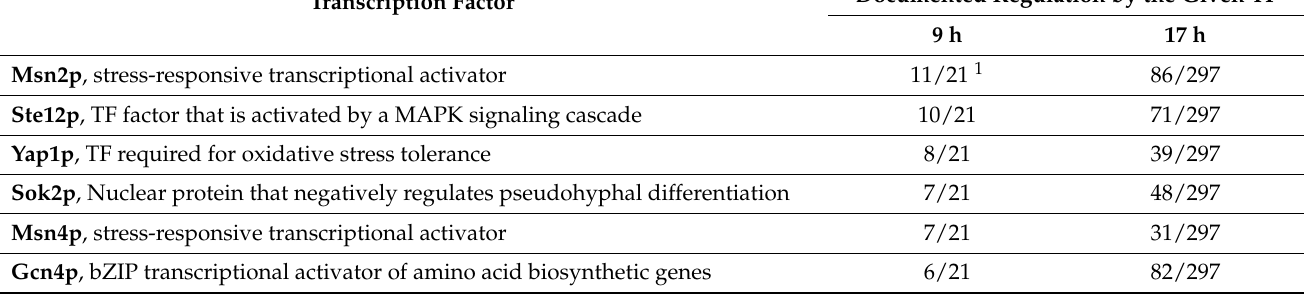
Transcription Factor